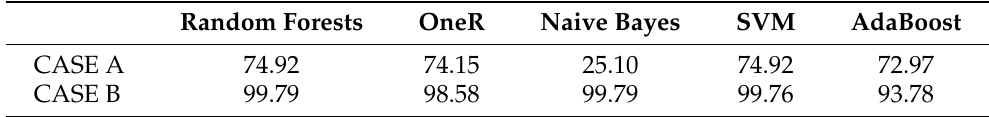
Table 3. Detection rate (%) for CASES A and B.